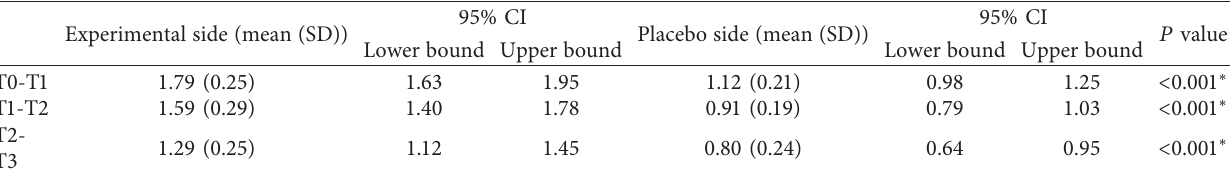
Table 1: Median values and standard deviation of canine movements in experimental and placebo groups with confidence interval and p values.